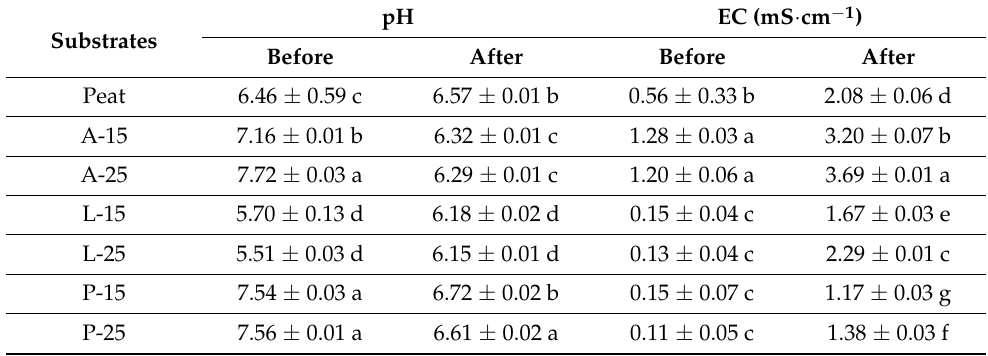
Table 6. The pH and EC values of substrates before and after cultivation of strawberry cv. ‘Honeoye’. pH EC (mS · cm − 1 ) Substrates Before After Before After